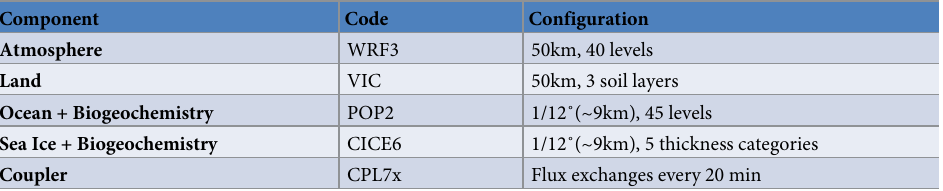
Table 1. Components, code and configuration of